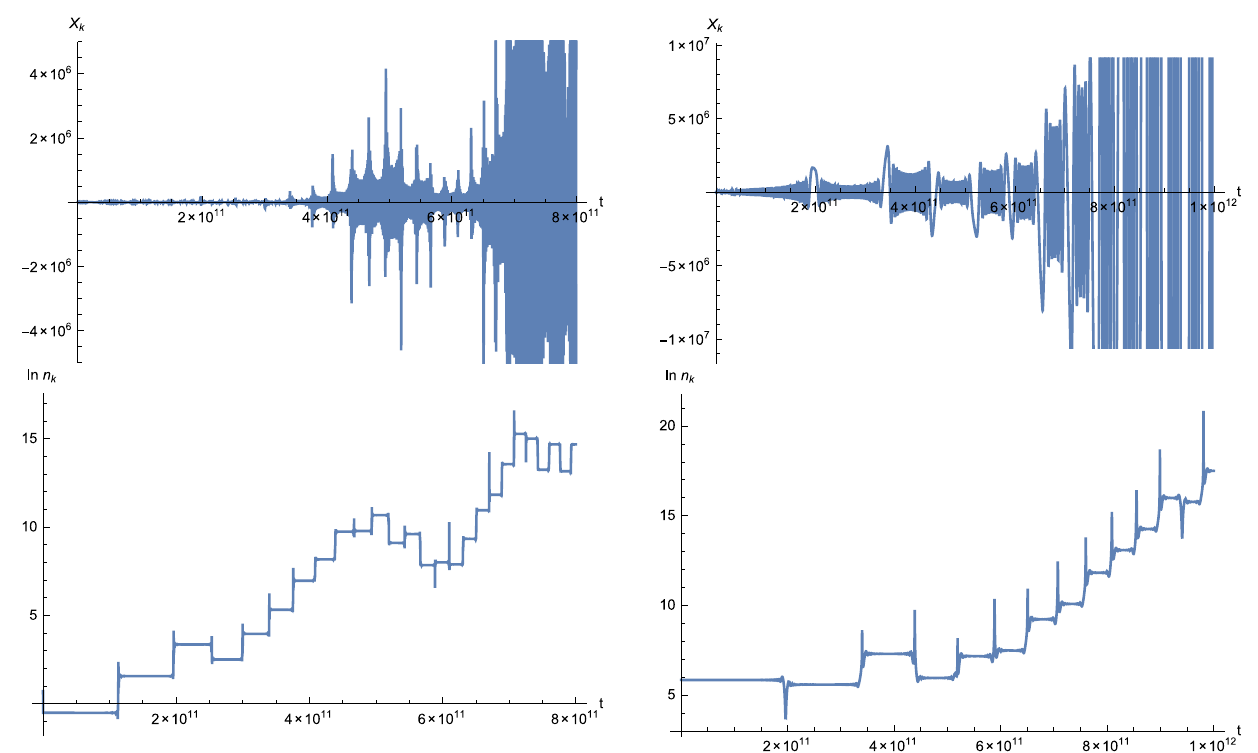
Fig. 4 The numerical plot of X k and ln n k in terms of the cosmic time t after curvaton domination. We choose the parameters as ξ = 1, M = 10 − 4 M p , m = 10 − 6 M p , g = 4 . 8 × 10 −